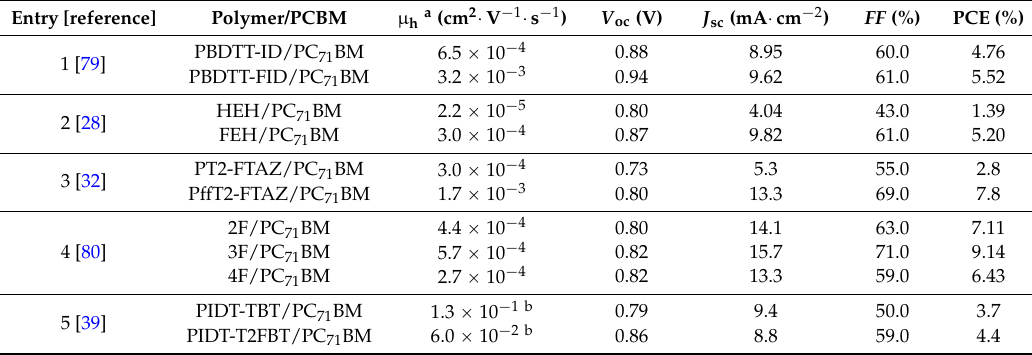
Table 5. Characteristic properties of polymer solar cells and charge carrier